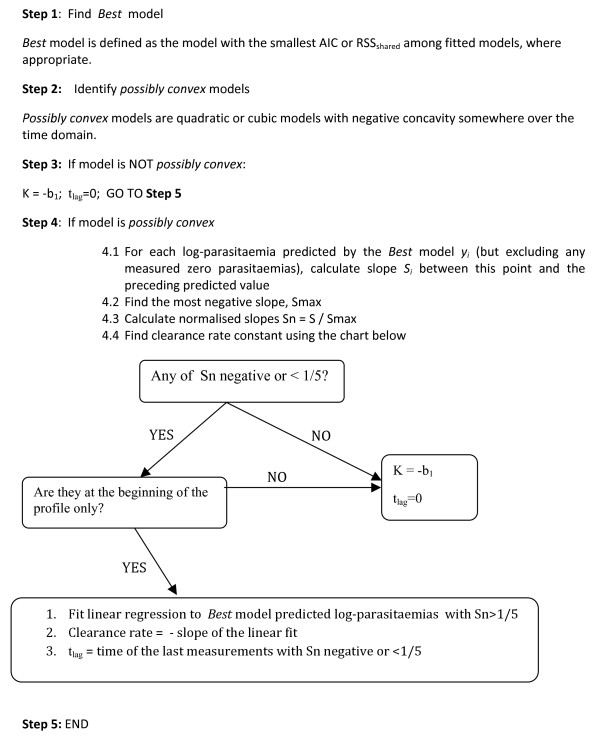
Diagrammatic representation of the process of estimating the clearance rate constant (K) and the duration of lag phase (tlag ) from individual patient parasite counts measured over time.